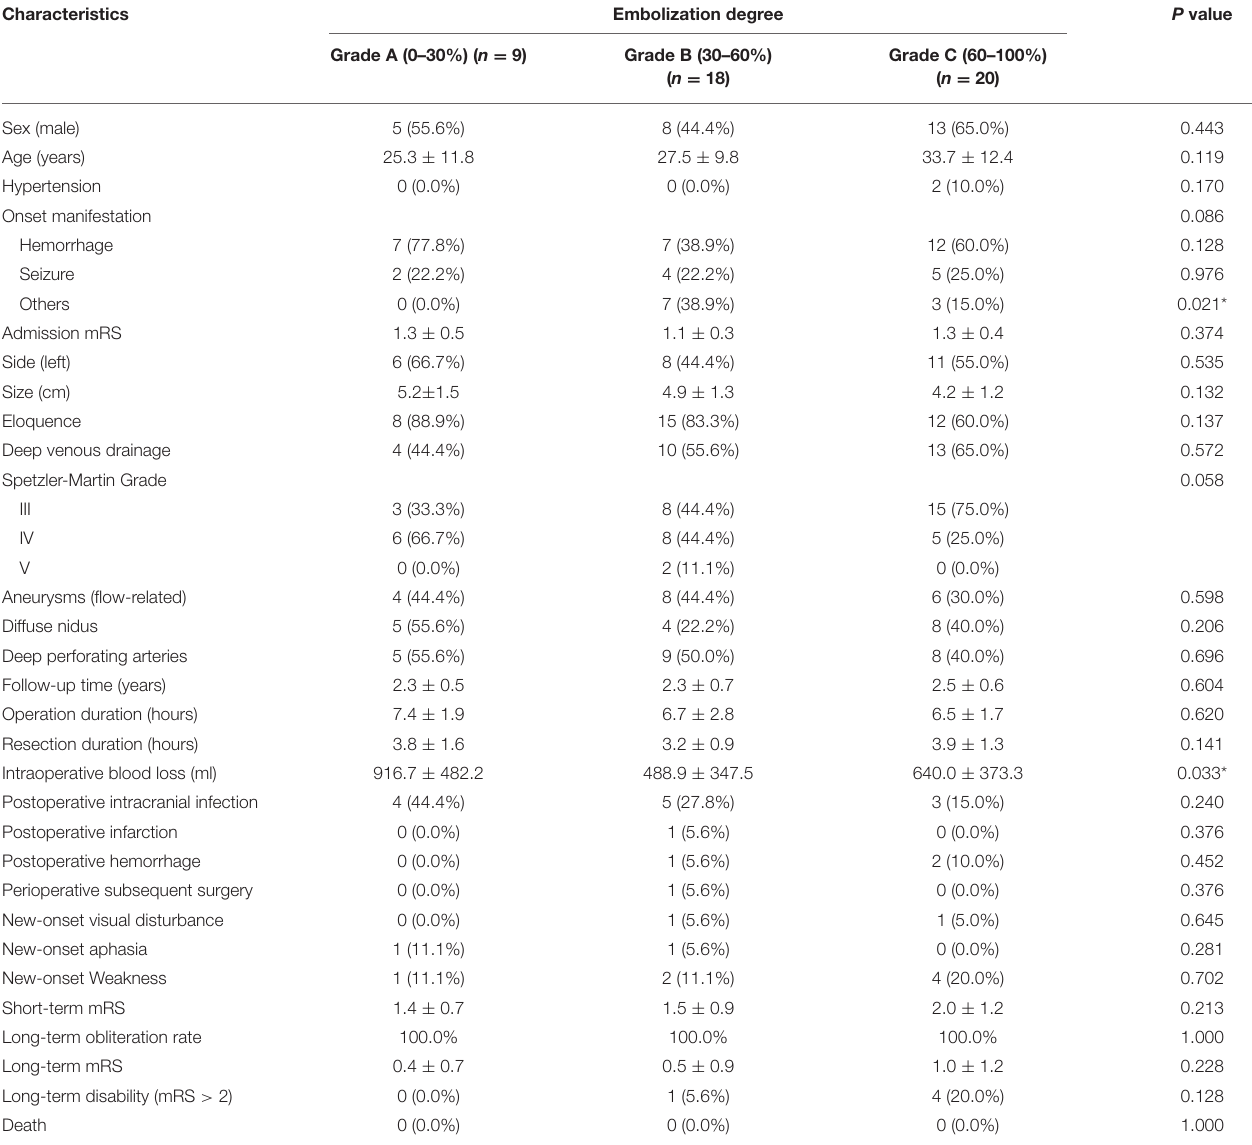
TABLE 4 | Comparison of clinical outcomes between different embolization degrees in the hybrid group.